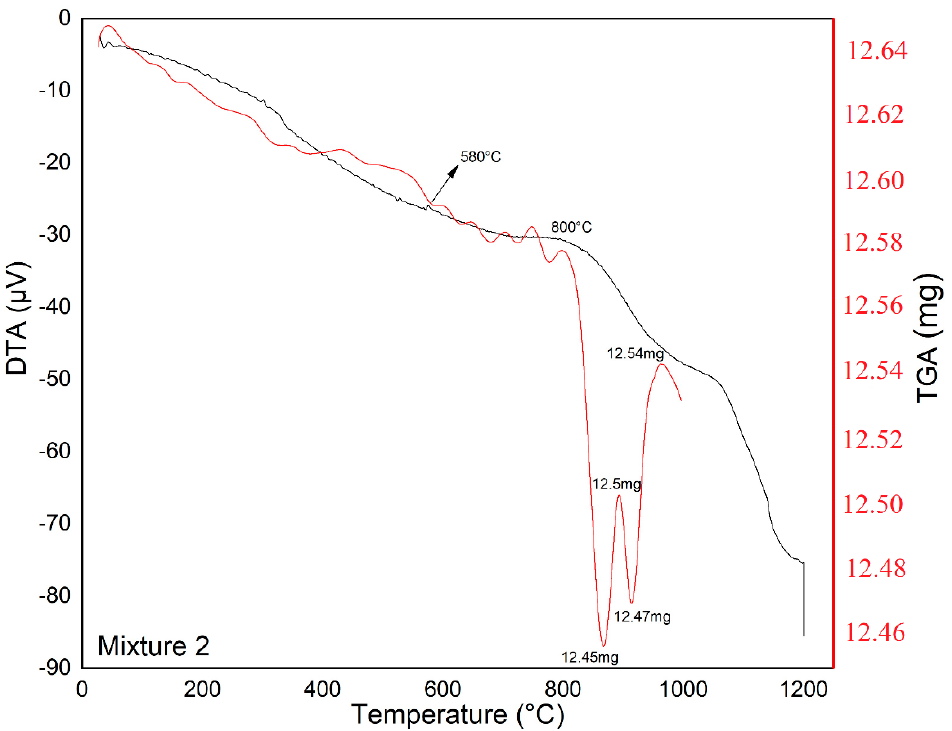
Figure 9. Thermal analysis (DTA-TGA) between 25 and 1200 °C for Mixture 2 showing characteristic temperatures.